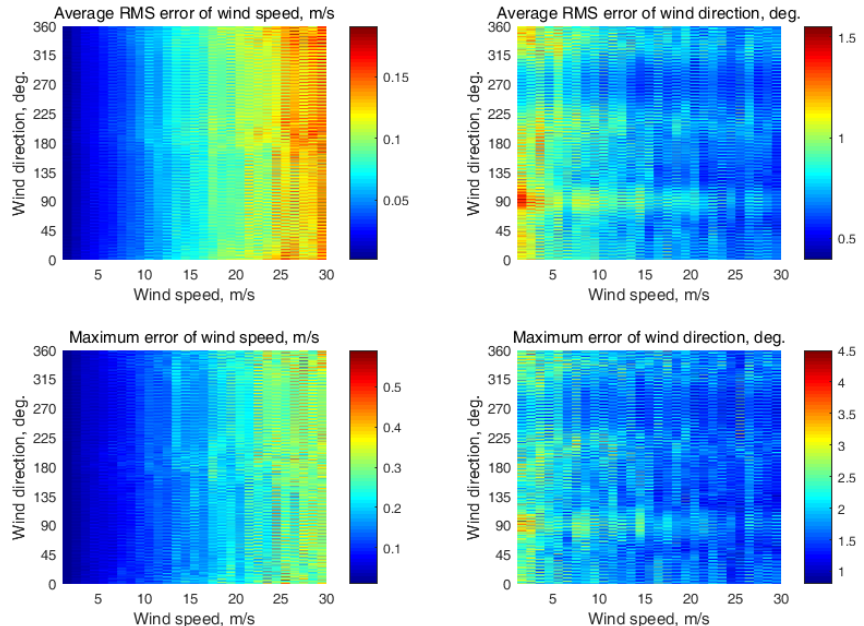
Figure A16. Semicircular wind retrieval results at the (35°, 40°, 45°) incidence angle combination.